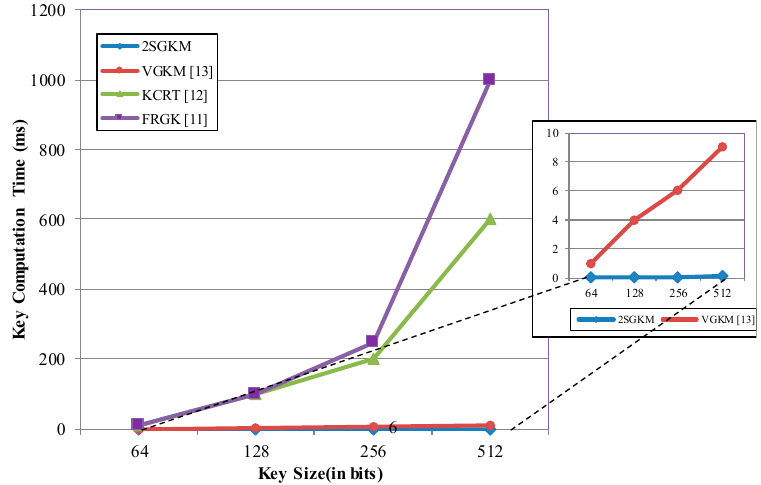
Figure 13. Group key generation time for different key sizes at group manager/trusted authority (GM/TA).